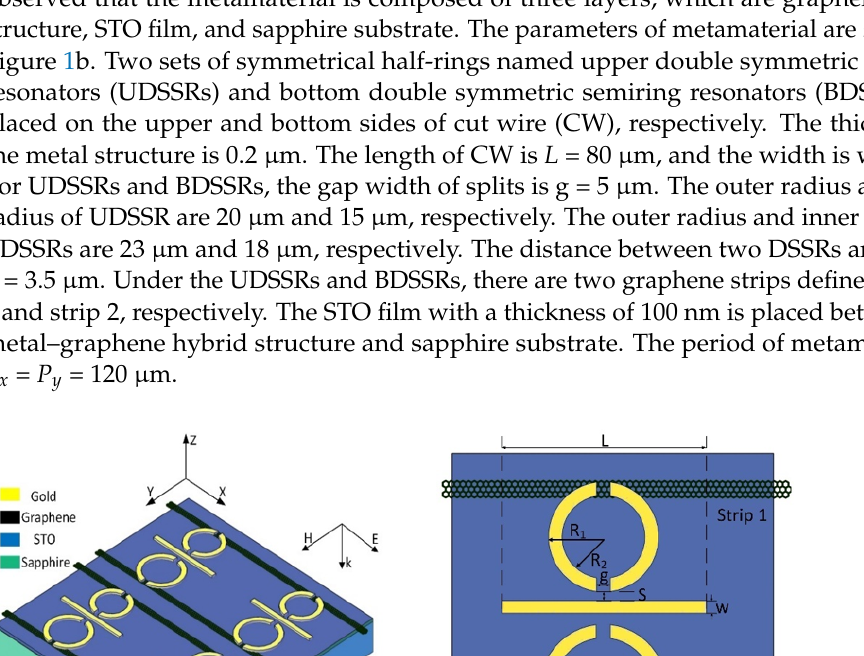
Figure 1. ( a ). Three-dimensional diagram of the hybrid metamaterial. ( b ) The top view of the unit cell.